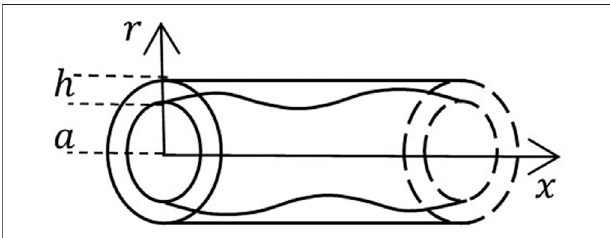
FIGURE 1 | A schematic of the geometric domain occupied by a vessel of radius a and wall thickness h . The model assumes a hollow horizontal axial symmetric circular cylinder whose wall has a fi xed outer boundary and an oscillatory inner